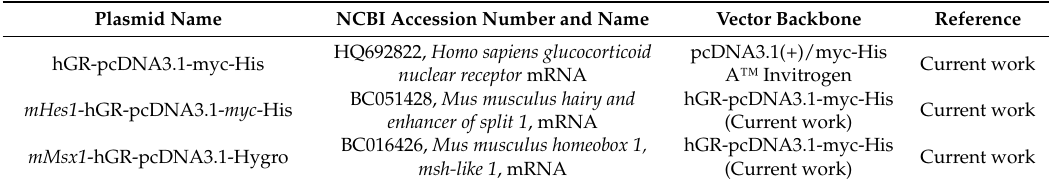
Table 1. Plasmid List. Gene sequences can be found on the NCBI GenBank